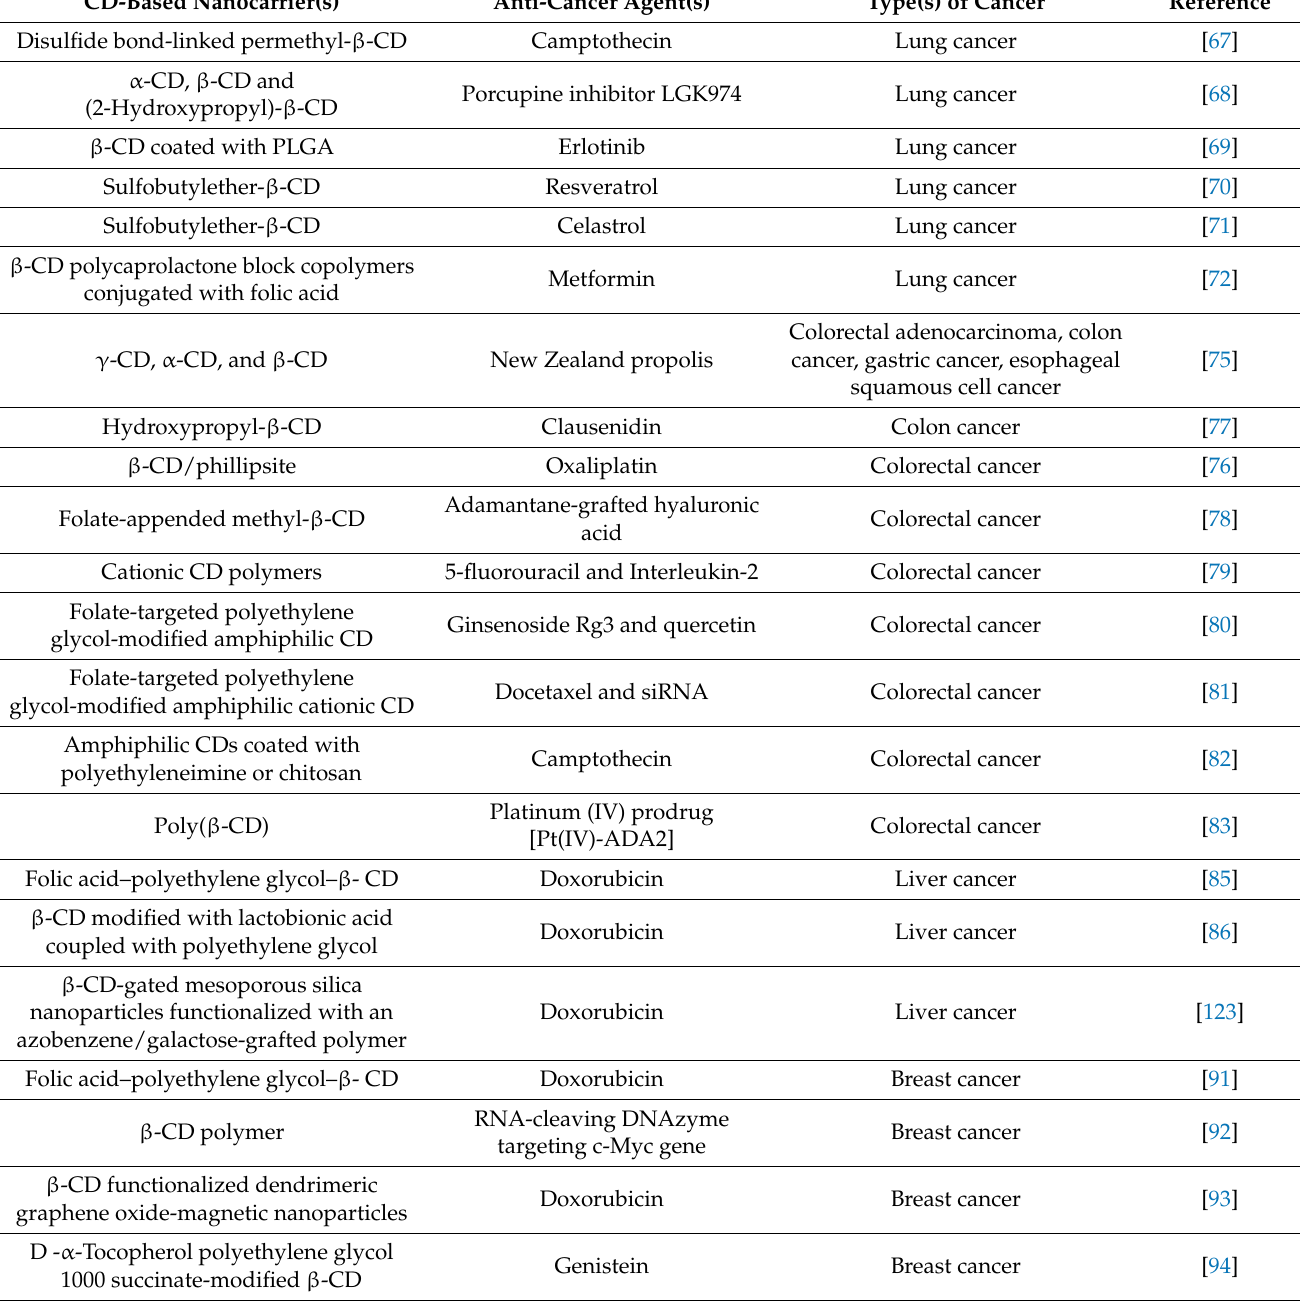
Table 2. Summative table of the discussed CD-based drug delivery systems correlated with the targeted types of